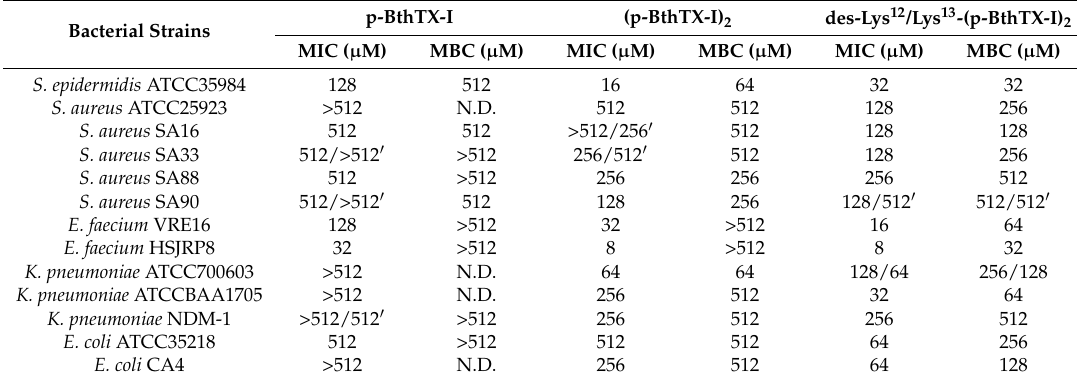
Table 3. Biological activities of the synthetic peptides (p-BthTX-I) 2 and des-Lys 12 /Lys 13 -(p-BthTX-I) 2 .